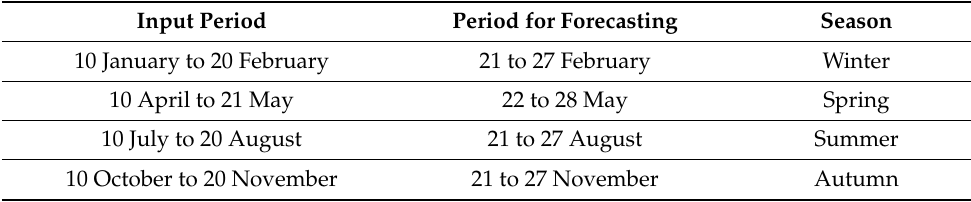
Table 1. The studied period in 2019 for the electricity market of Spain. Input